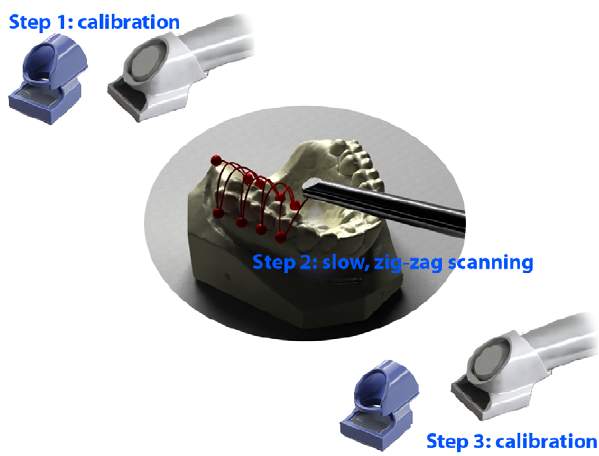
Figure 2. The technical principle of the iTero scanner. The iTero scanner uses confocal laser scanning in which a laser beam (red) is projected on an object. Via a beam splitter, the reflected beam (purple) is led through a focal filter so that only the image that lies in the focal point of the lens can project on the sensor. As the focal distance is known, the distance of the scanned part of the object to the lens is known (the focal distance). To scan the whole object, the lens is moved up and down, each time projecting a part of the object onto the sensor.